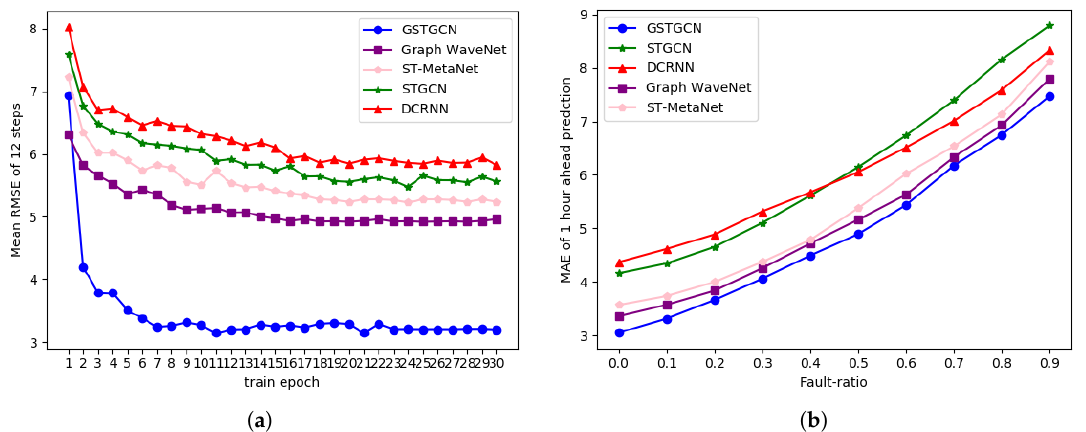
Figure 9. ( a ) Test Mean RMSE of 12 steps versus the number of training epochs on PeMSD7 dataset. ( b ) Fault-tolerance comparison on PeMSD7